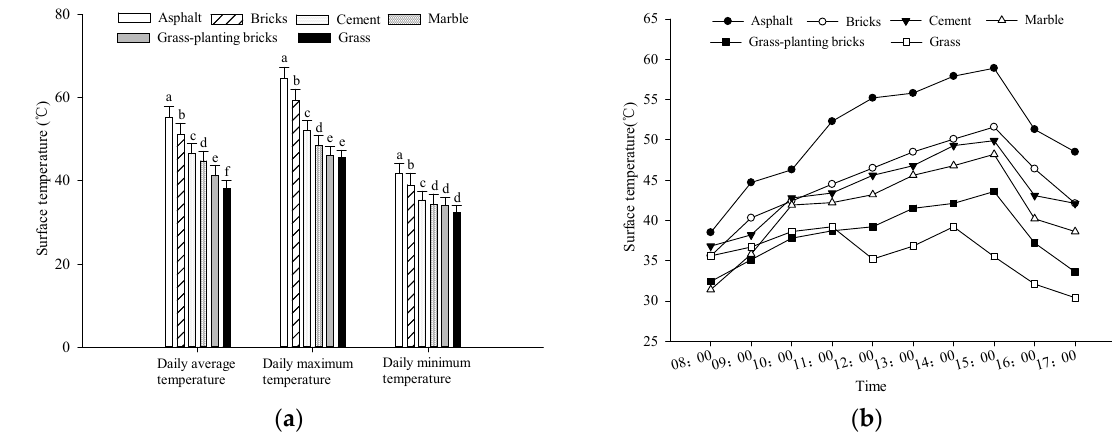
Figure 2. Surface temperature of the urban underlying surface environment. ( a ) Different underlying surface temperatures; ( b ) daily changes in surface temperature.